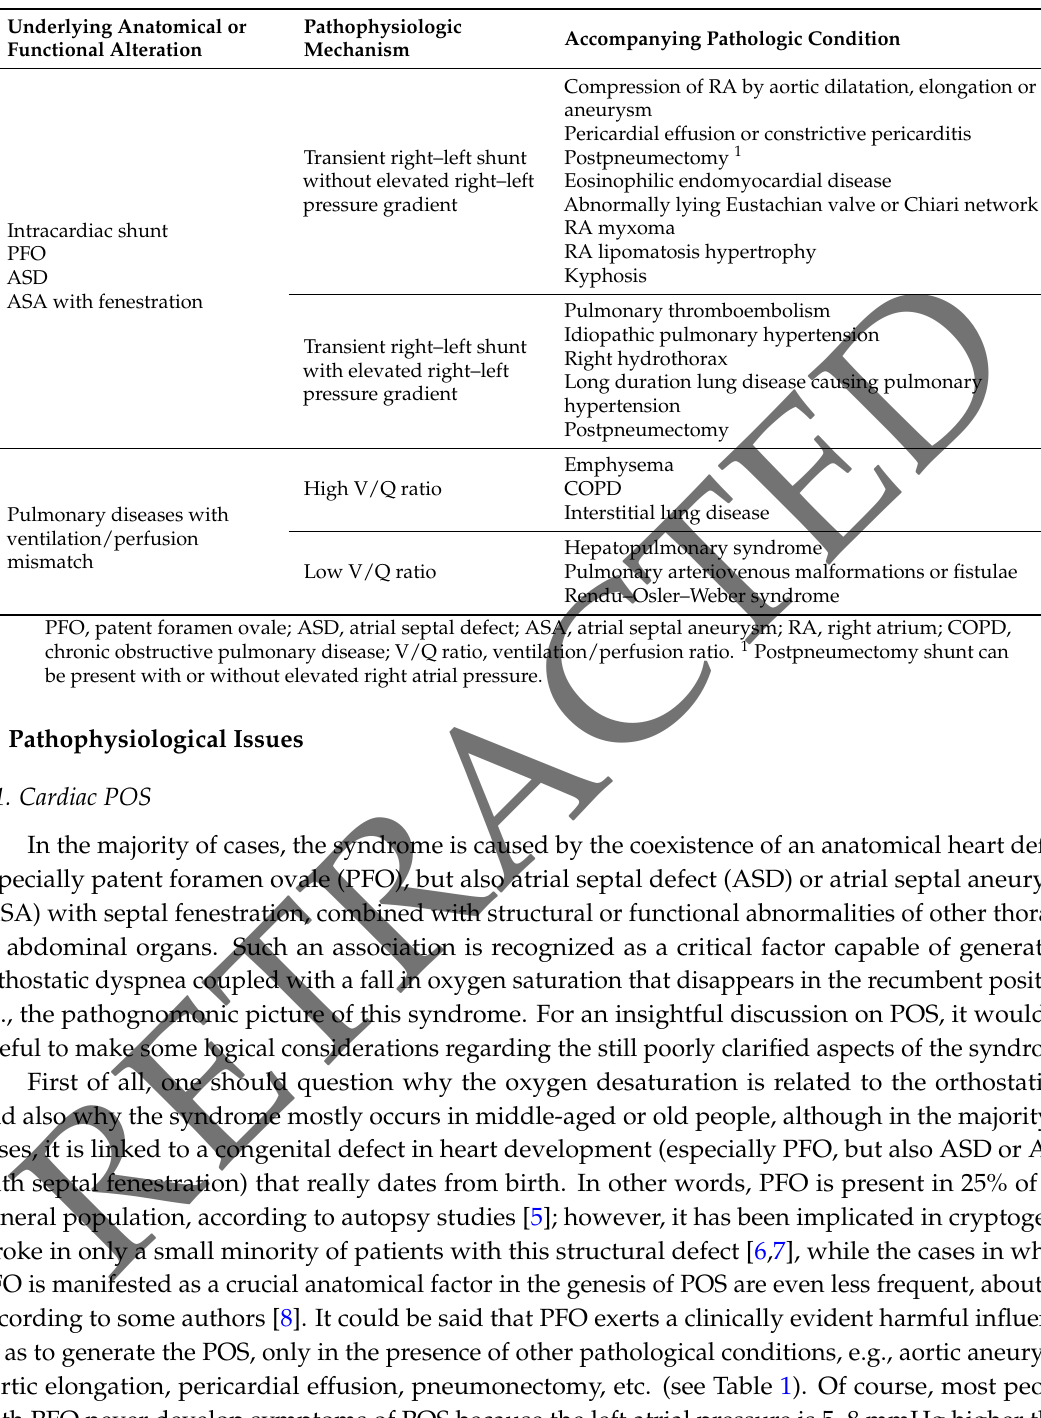
Table 1. Possible causes of platypnea–orthodeoxia